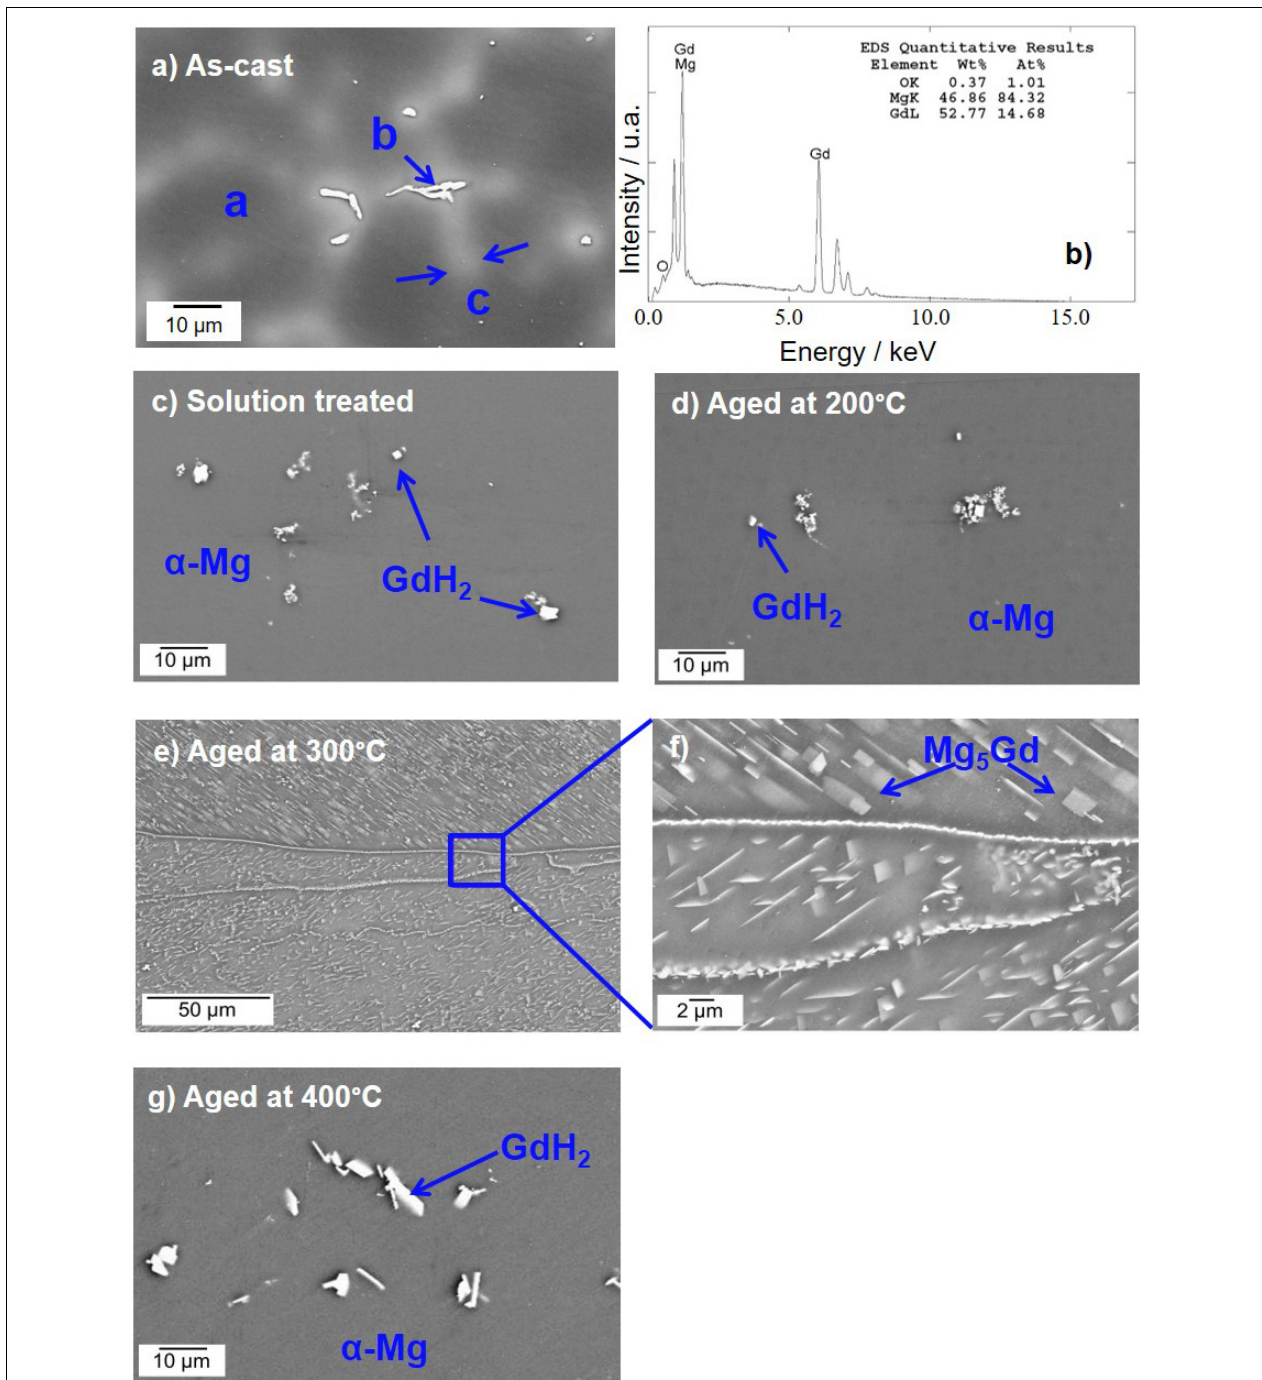
FIGURE 2 | SEM micrographs of Mg-10Gd alloy: (a) as-cast microstructure, letters a, b, c, corresponds to α -matrix, Mg 5 Gd intermetallic phases and Gd enrichment zones, respectively, (b) typical EDS analysis of the “b” particles (c) solution treated microstructure, after 24 h at 540 ◦ C, heat treatments for 24 h (d) at 200 ◦ C, (e) at 300 ◦ C, (f) higher magnifications showing the precipitates of Mg 5 Gd phase and (g) at 400 ◦ C.